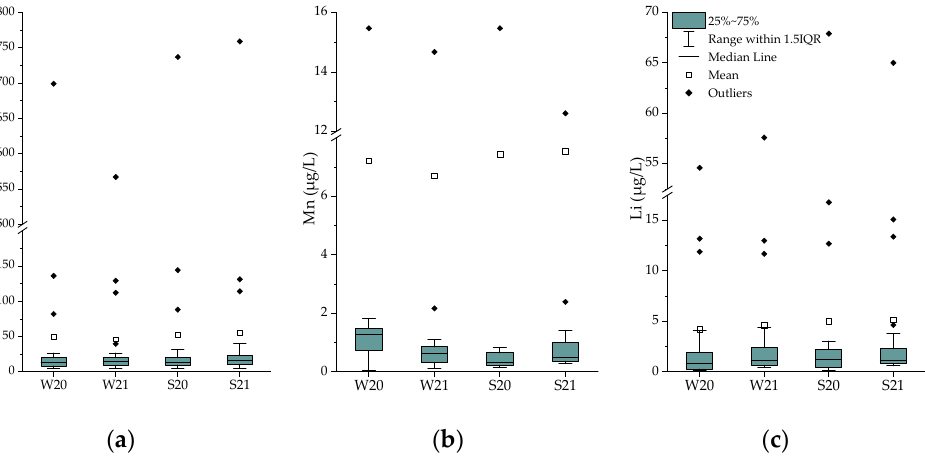
Figure 4. Boxplot of Ba ( a ), Mn ( b ), and Li ( c ) concentrations ( µ g/L) in groundwaters in winter (W) and spring (S) seasons of 2020 (20) and 2021